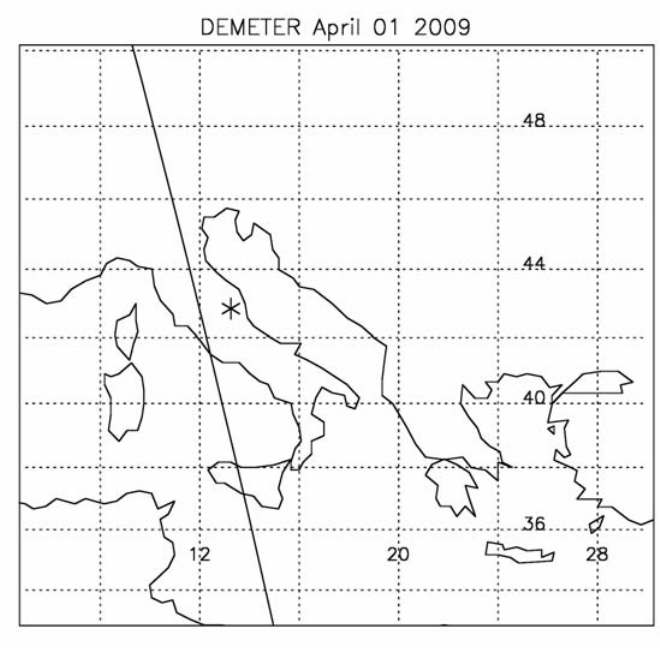
Figure 1. Map showing the epicenter of the April 6 L’Aquila earthquake (*) and the orbit of the DEMETER satellite on April 1, 2009. The point of closest approach is a larger distance from the epicenter (677